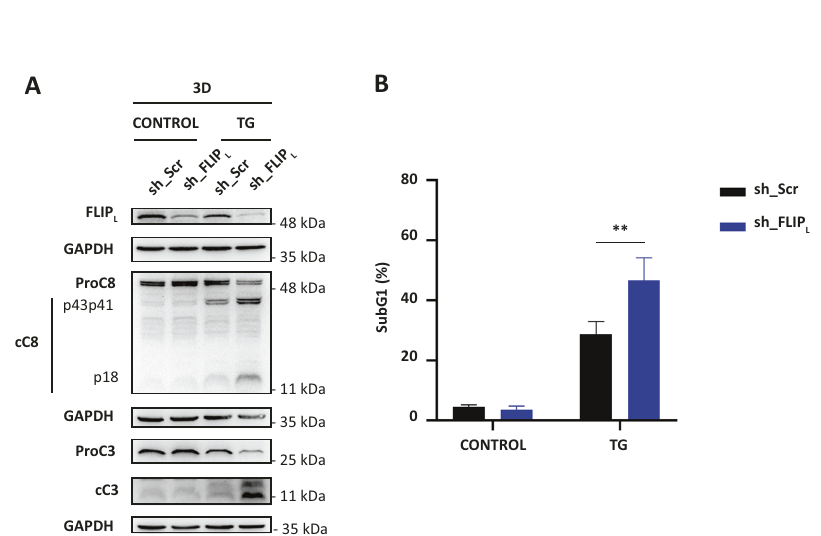
Fig. 8 Effect of cFLIP L knockdown on ER stress-induced apoptosis in multicellular tumor spheroids. Spheroids (10 days) of HCT116 shScr or shFLIP L cells were treated with TG (100 nM) for 3 days. A cFLIP L levels and processing of caspase-8 and -3 were assessed in whole-cell extracts by western blotting using GAPDH as protein-loading control. Blots are representative of three independent experiments. B Apoptosis was determined following TG treatment by subG1 analysis as described under “ Materials and methods ” (** p ≤ 0.005; two-way ANOVA. Tukey ’ s multiple comparisons test).